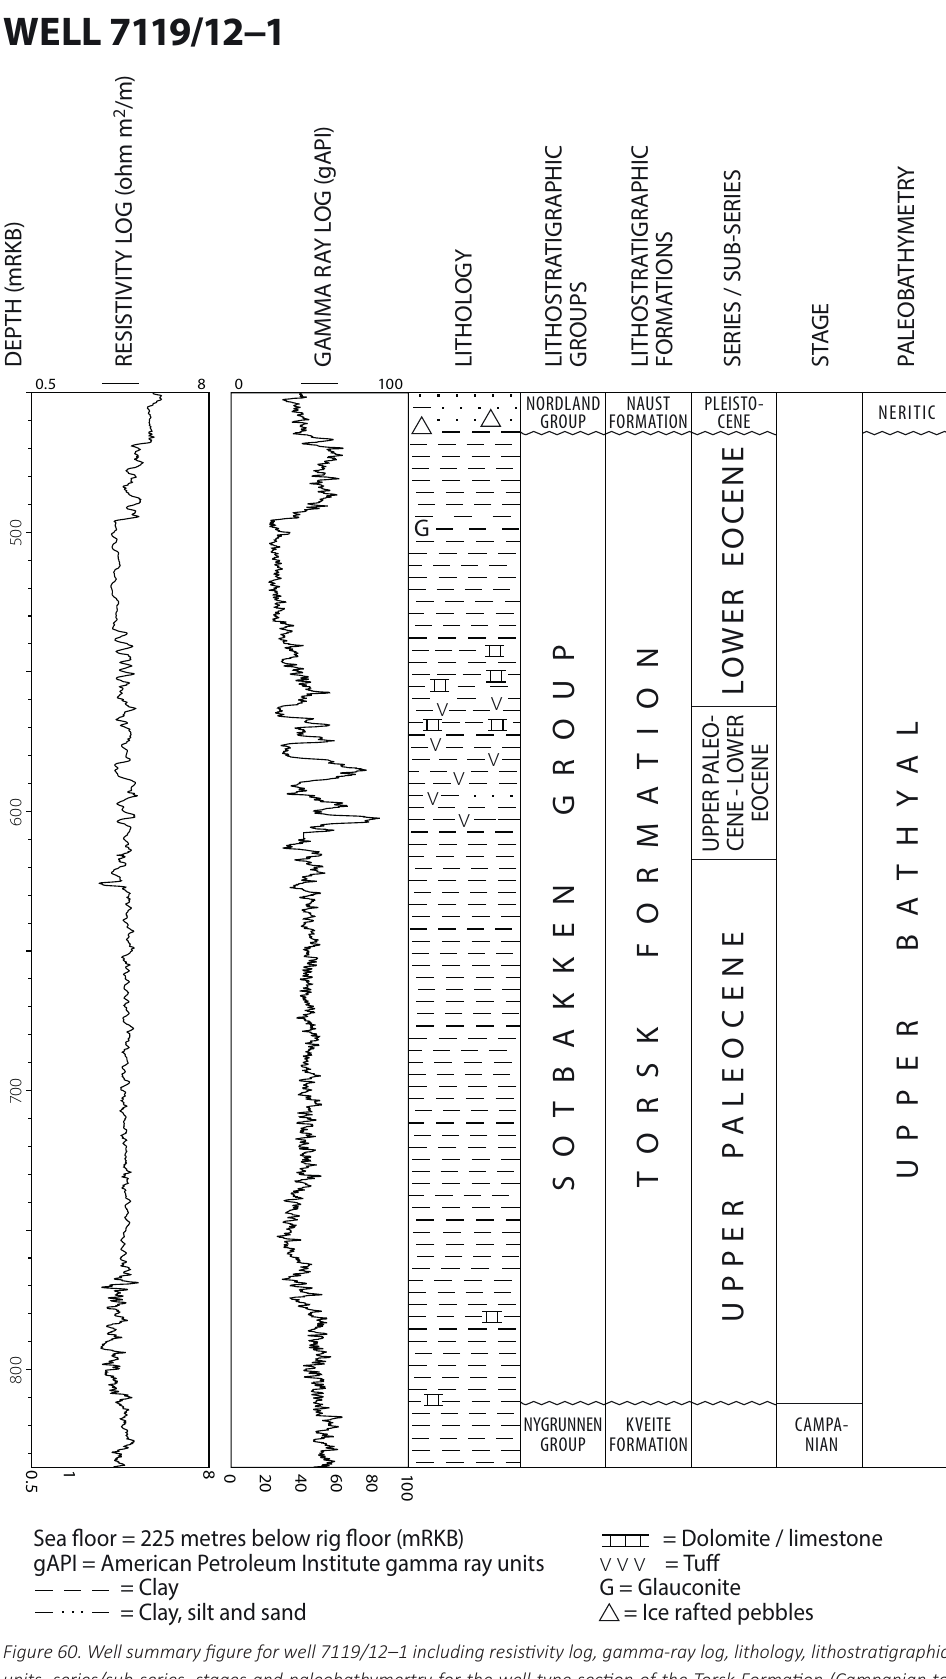
Sea floor = 225 metres below rig floor (mRKB) gAPI = American Petroleum Institute gamma ray units